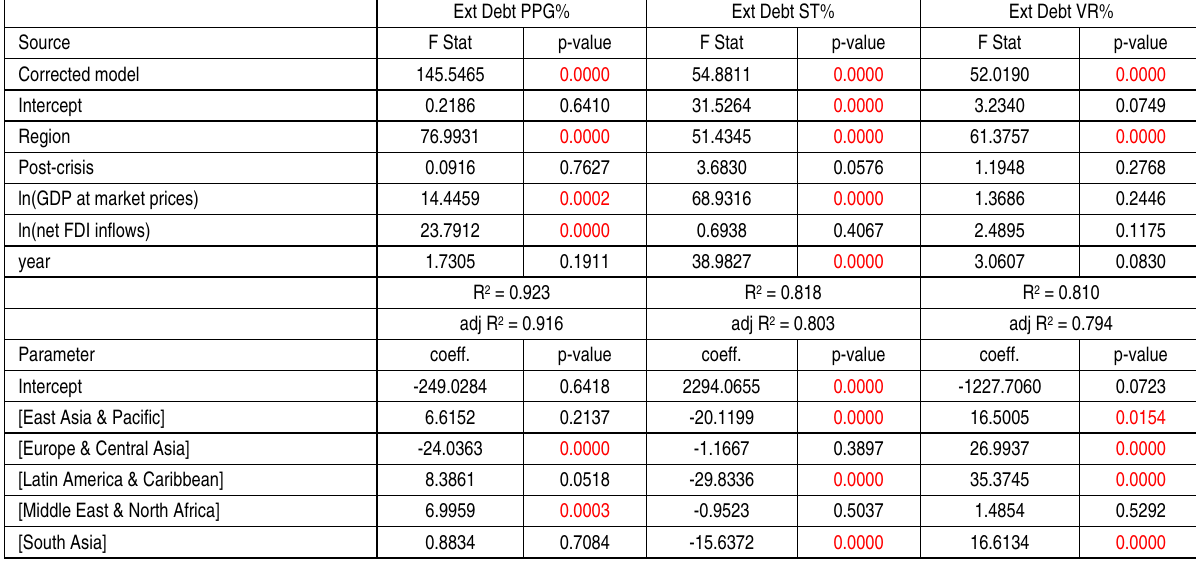
Table 11. Fixed effects panel regression for PPG% external debt, ST% external debt, and VR% external